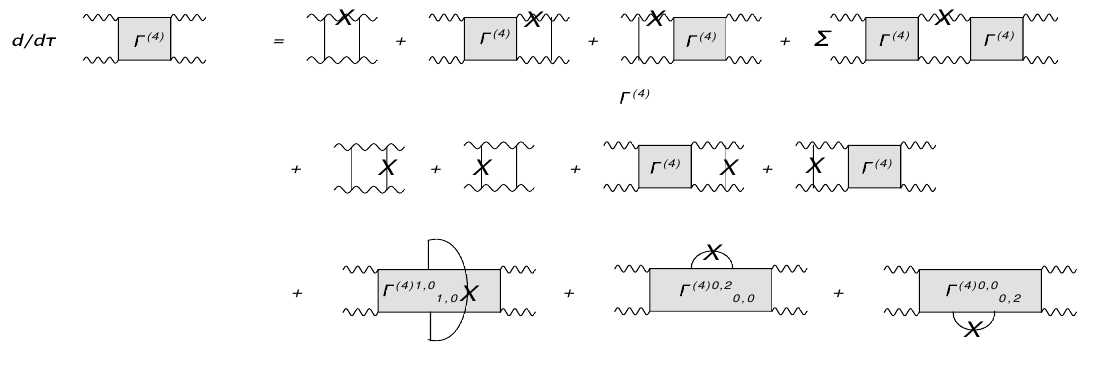
Figure 14 . Flow equation for the 1PI 4-point function.